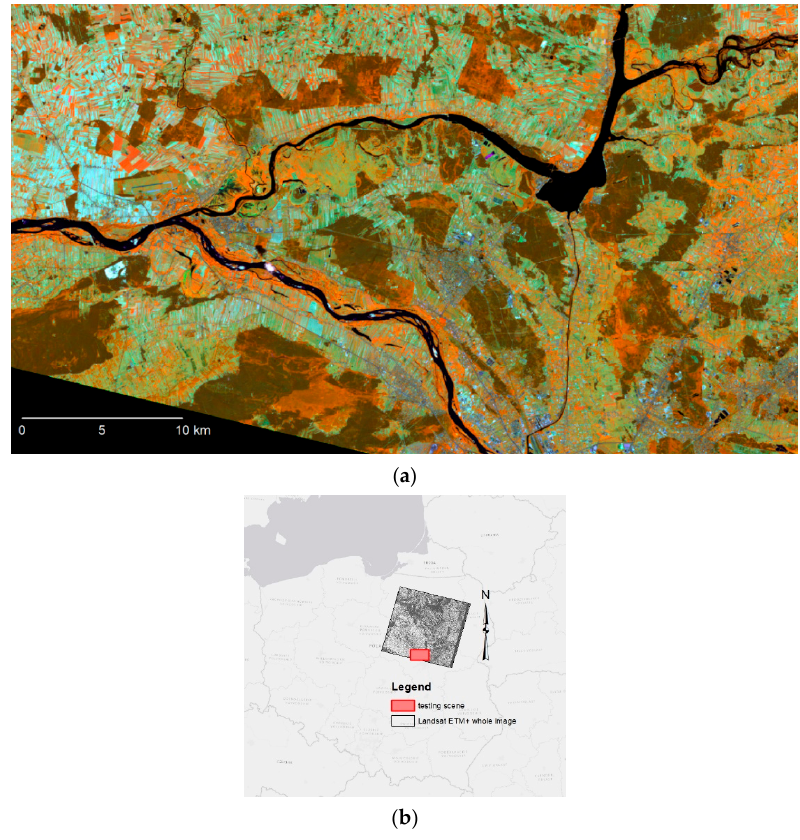
Figure 1. Testing scene of RS algorithm: ( a ) part of Landsat ETM+ satellite image (ID = Testing scene of RS algorithm: ( a ) part of Landsat ETM + satellite image LE71880232000128EDC00); Red-Green-Blue (RGB) composition of bands (4, 5, 3). ( b ) Landsat ETM+ (ID = LE71880232000128EDC00); Red-Green-Blue (RGB) composition of bands (4, 5, 3). whole satellite image and testing scene (red)—location in Poland. ( b ) Landsat ETM + whole satellite image and testing scene (red)—location in